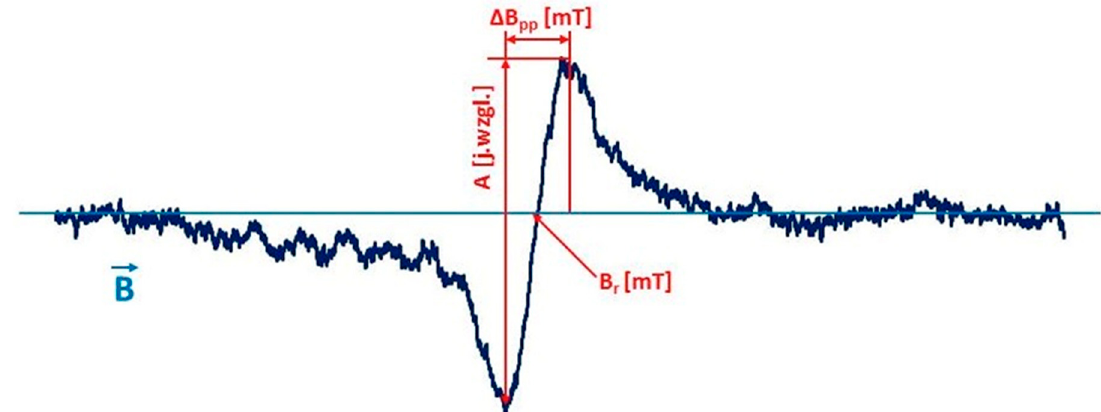
Figure 24. An exemplary EPR spectrum of a burnt skin sample recorded in the form of the first derivative of absorption with marked line amplitude (A), line width ( Δ B pp ), and resonance magnetic induction (B r ).